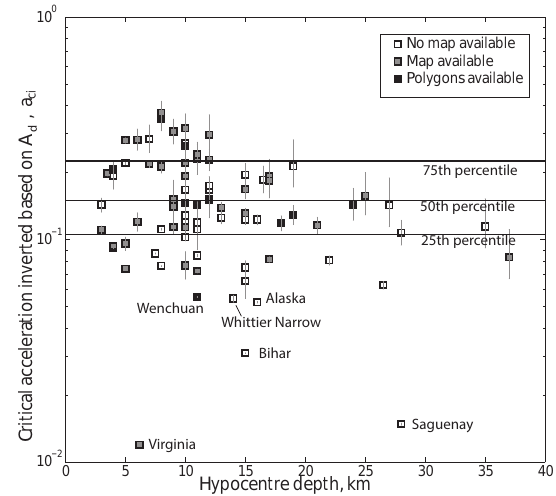
Figure 6. Inverted value of the threshold of acceleration for dam- age, a c , against hypocentral depth. Most values cluster between 0.1 and 0.2, but some events (with their name tags displayed) have ex- ceptionally low inverted